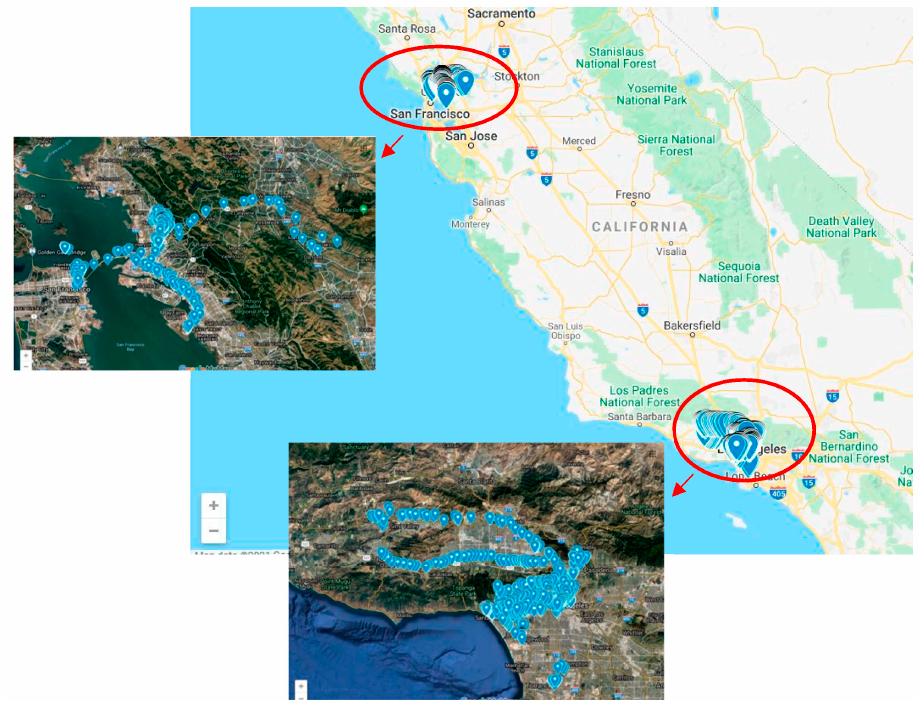
Figure 6. The sequence of check-ins recorded by the user with ID 2 in the Gowalla dataset.